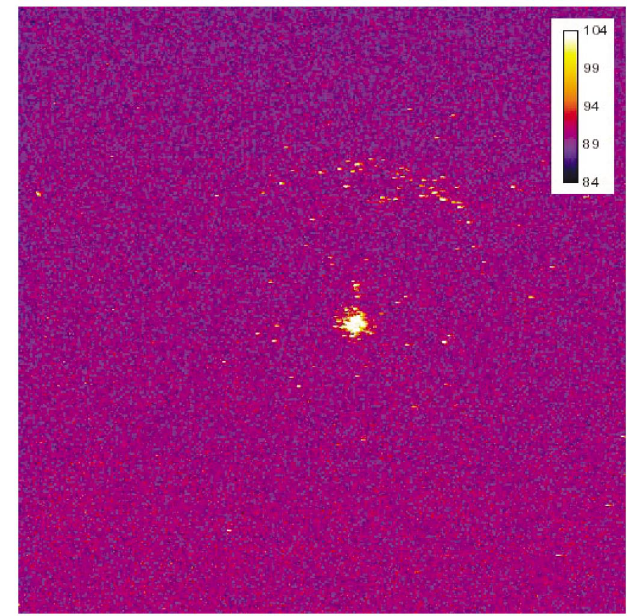
FIG. 17. (Color) Evidence of beam halo formation in velocity space. Image from a pinhole positioned at end of the final-focus system and at the center of the beam, and measured at the focal